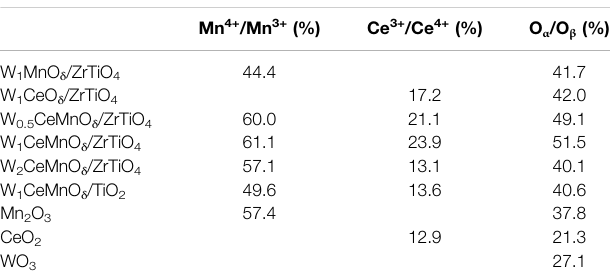
TABLE 3 | XPS result of W x CeMnO δ /3DOM ZrTiO 4